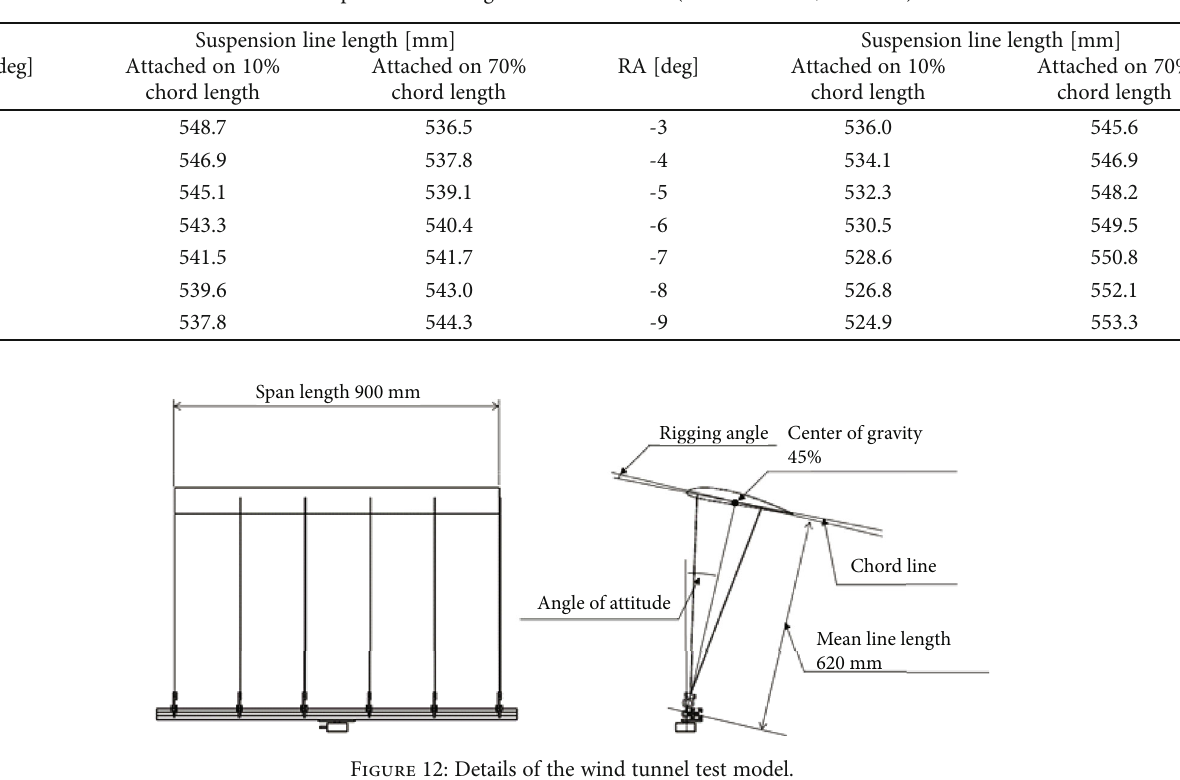
Table 4: Suspension line length to determine RA (MLL: 0.54mm, CG: 45%).